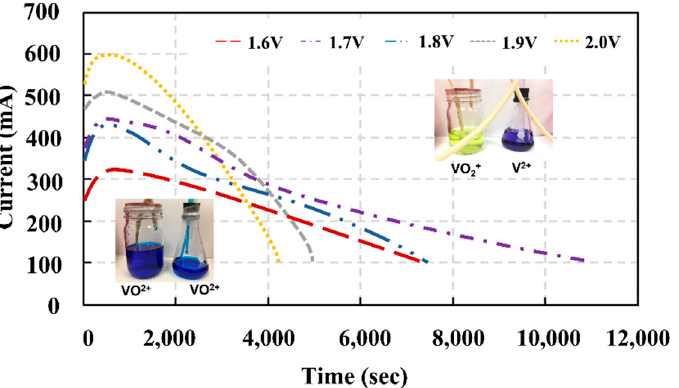
Figure 5. The current profile of the VRFB cell as a function of time during the electrolyte preparation period .